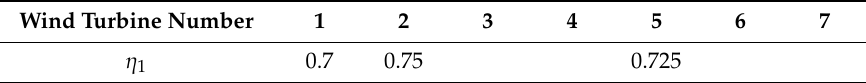
Table 2. The axial induction factor η 1 used for each disk in the series of configuration.